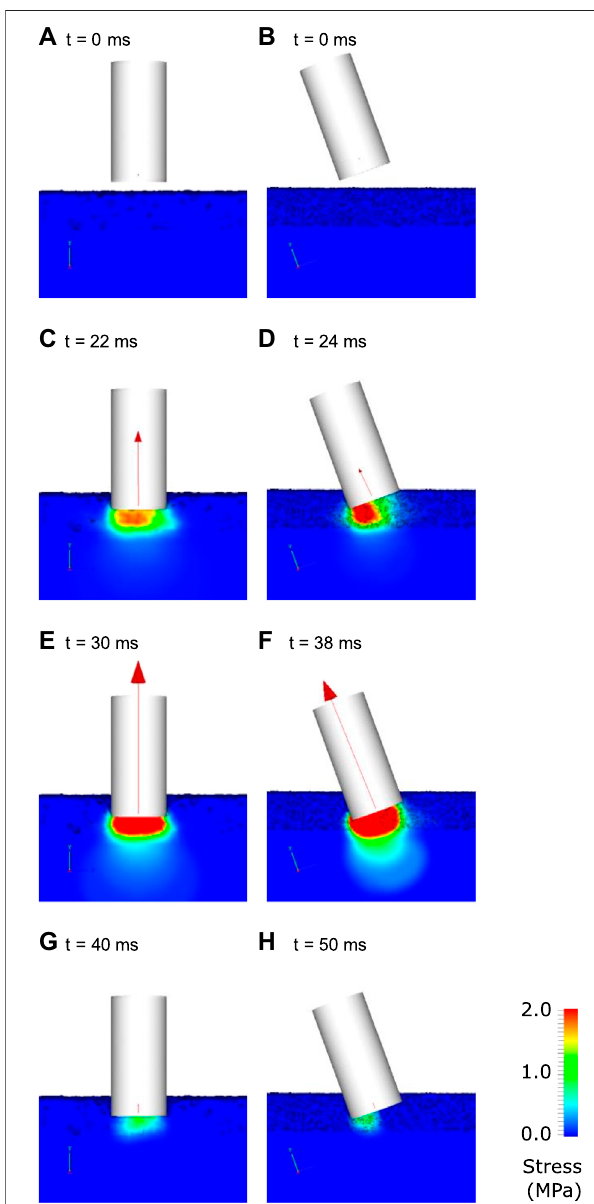
FIGURE7| Visualisationoftheinteractionofthetracktestingdevicewith groundforthe caseadirt track. Theleftcolumns showthe resultsforavertical impact and the right column shows results for an angled impact. The track is coloured by von Mises stress at various times indicated by labels (A – H) . The net force on the TTD is shown as a red vector.